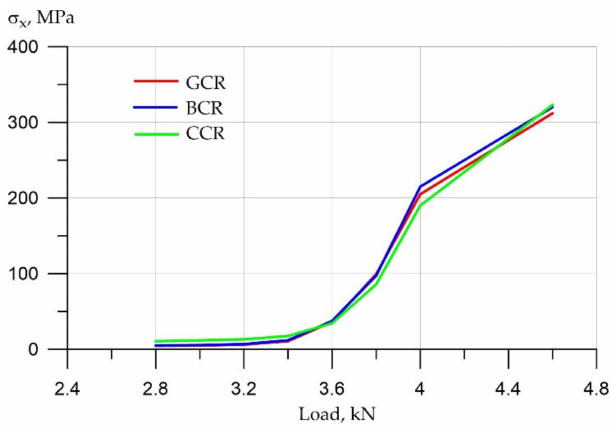
Figure 13. Tensile stresses in various types of reinforcement.